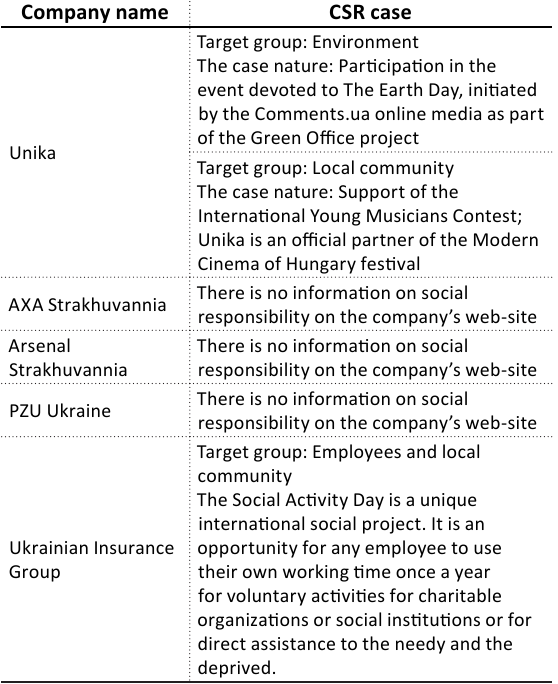
Table 3. CSR practices of the Ukrainian insurance